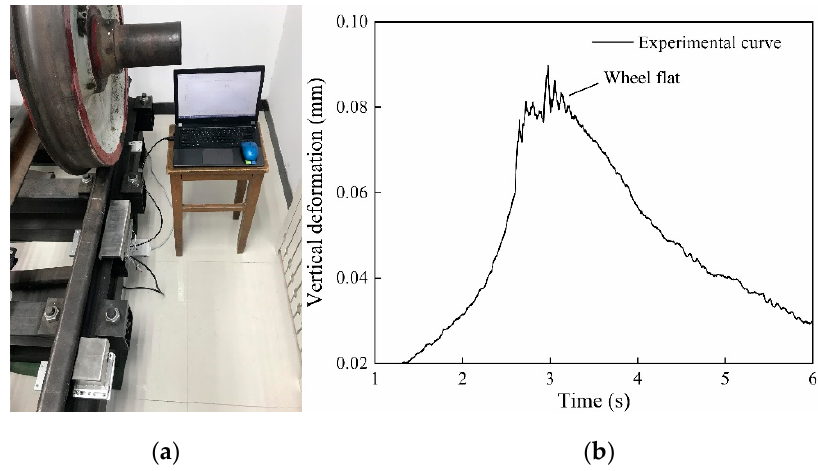
Figure 15. The wheel flat detection experiment: ( a ) The diagram of experimental devices; ( b ) The measurement waveform of wheel flat.